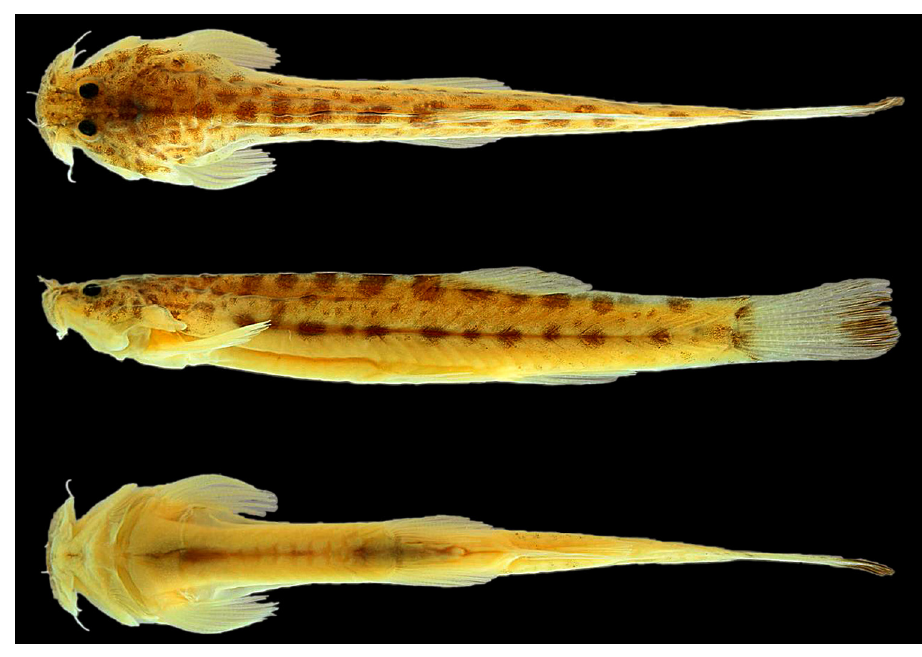
FIGURE 21 | Scleronema operculatum (UFRGS 18086; 40.0 mm SL), Brazil, Rio Grande do Sul, Rosário do Sul, sanga Santo Antônio, tributary to rio Ibicuí da Armada, lower rio Uruguay.